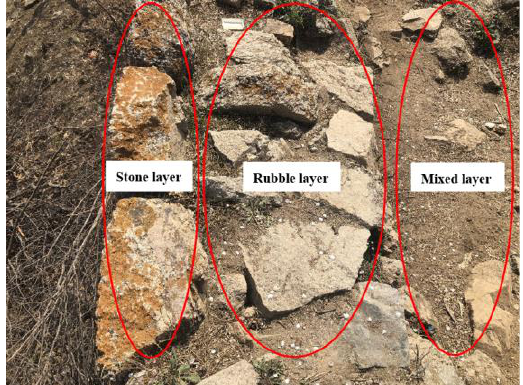
Figure 3. Base wall configurations and components.